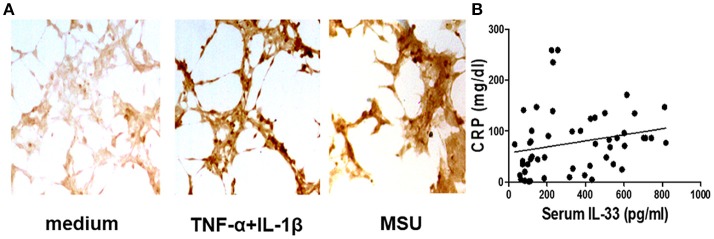
Corrrelation of the increased IL-33 with CRP in gout patients (A). The synovial fibroblasts from synovial fluids were harvested to stimulate with TNF-α/IL-1β and MSU for 24 h, and then were stained with anti-IL-33 antibody by immunohistochemistry analysis. The results shown are from one of three independent experiments (B). The sera collected from gout patients were used to analyze IL-33 levels by ELISA. The determination of linear relationships between IL-33 expression and CRP in gout patients was performed by Spearman correlation coefficient (r = 0.38, p = 0.005).